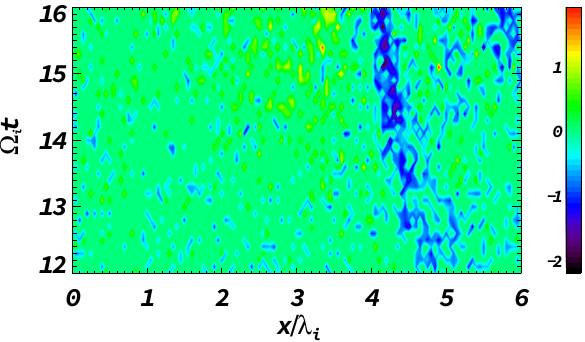
Figure 5. The time evolution of the electron flow velocity parallel to the magnetic field at y/λ i = 6 .